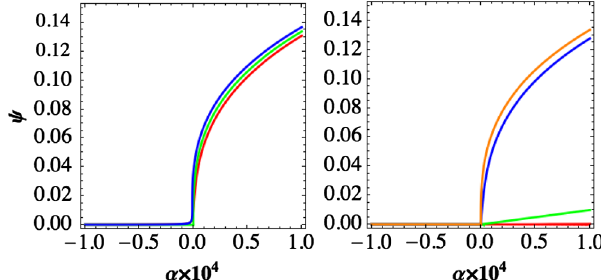
FIG. 3. (left) Retarded angle c as a function of (cid:4) when (cid:1) ¼ 1 and (cid:4) (cid:8) 1 , for x ¼ (cid:1) 10 (cid:1) 4 ; 0 ; 10 (cid:1) 4 (red, green, blue curves, respectively). (right) Retarded angle c as a function of (cid:4) when x ¼ 0 and (cid:4) (cid:8) 1 , for (cid:2) ¼ 2 ; 10 ; 100 ; 1000 (red, green, blue, orange curves,